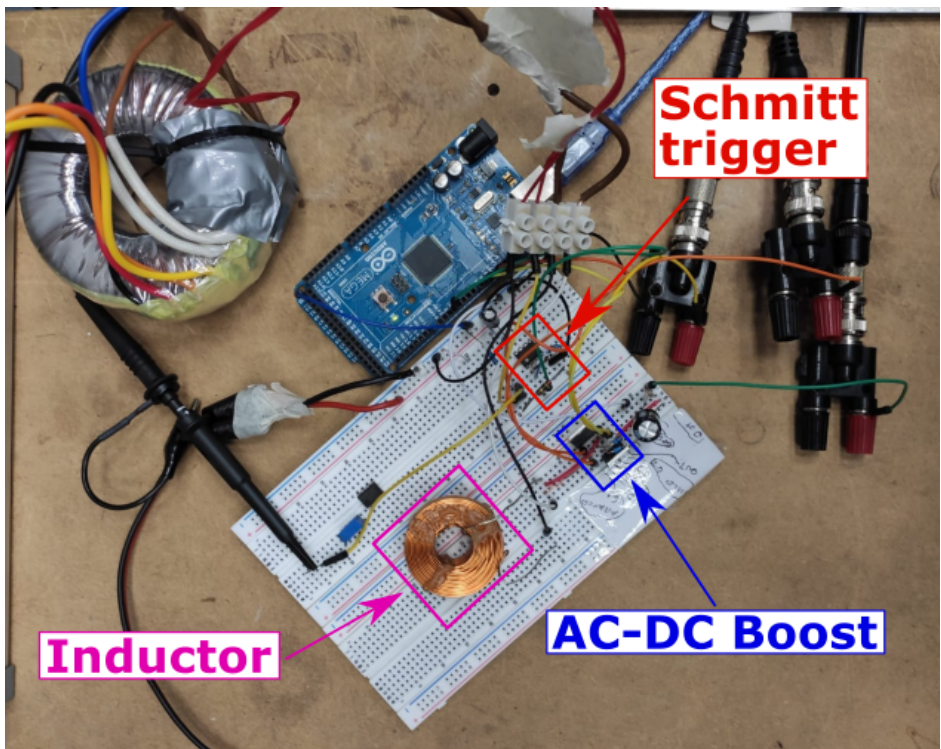
Figure 7. Picture of the setup sketched in Figure 6 and used for the experimental